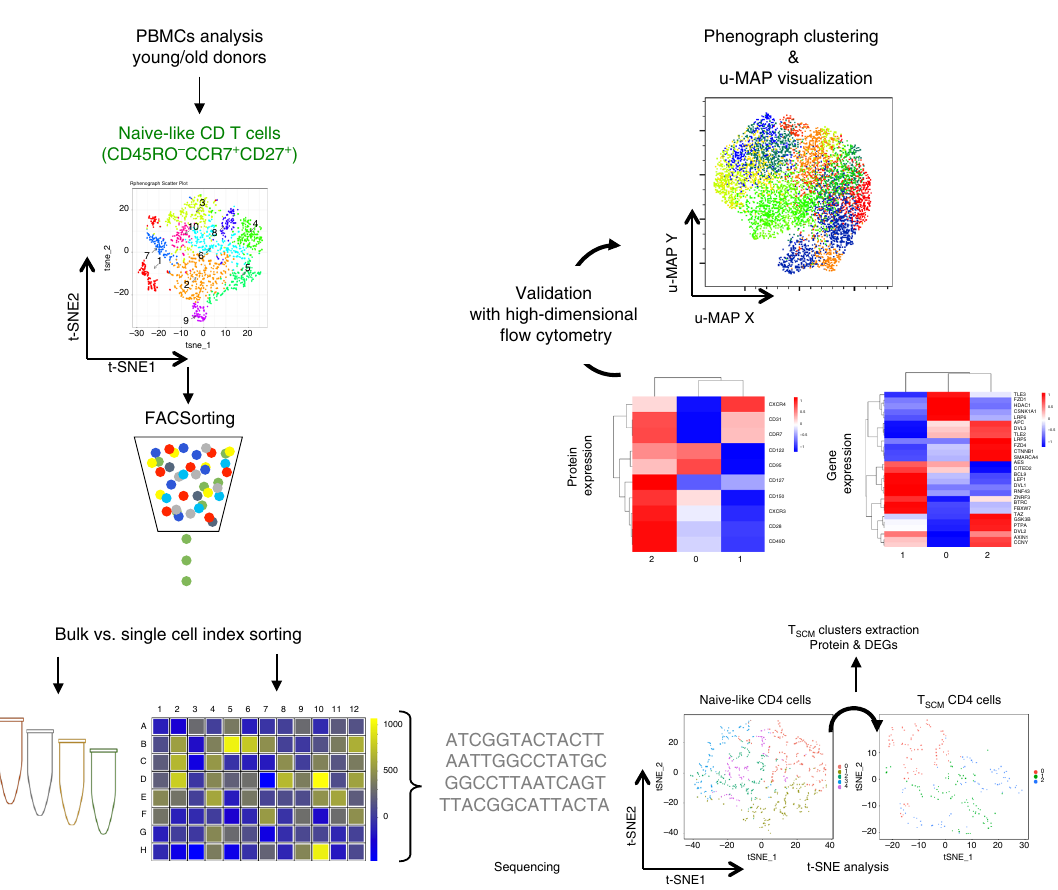
Fig. 1 Study design. Work fl ow of high-dimensional analysis to characterize the heterogeneity of human CD4 T SCM cells. Arrows represent in vitro or in silico experiments, respectively. CCR7 + CD45RO − CD27 + CD4 T cells from young ( n = 4) and elderly donors ( n = 4) were index sorted and distributed as single cells in 96-well plates (two plates per donor) (1). The MFI corresponding to surface protein expression for each individual cell was recorded for CD28, CD31, CD49d, CD95, CD122, CD127, CD150, CXCR3, CXCR4, and CCR7. A library of DNA sequences was established after the RNA extraction of each individual cell (2). The analysis of single-cell RNA-seq data was reported with t-SNE to identify the clusters of cells with similar pro fi le of gene expression (3). Levels of CD95 protein expression were overlaid on the different clusters to identify clusters that were enriched in T SCM (4). The clusters corresponding to CD4 T SCM were extracted and re-analyzed by t-SNE (5). The heterogeneity of CD4 T SCM was validated with FACS Symphony high- dimensional fl ow cytometry staining